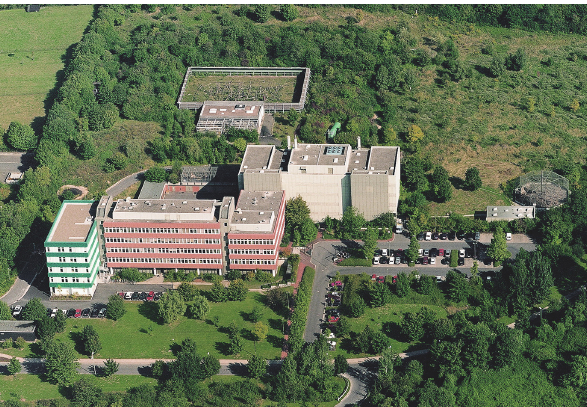
Figure 10. Bird’s-eye view of the German Primate Center with its three facility wings, from the left: office wing, laboratory wing, functional wing and the animal house, with the outdoor enclosure at the rear (picture from DPZ archive,